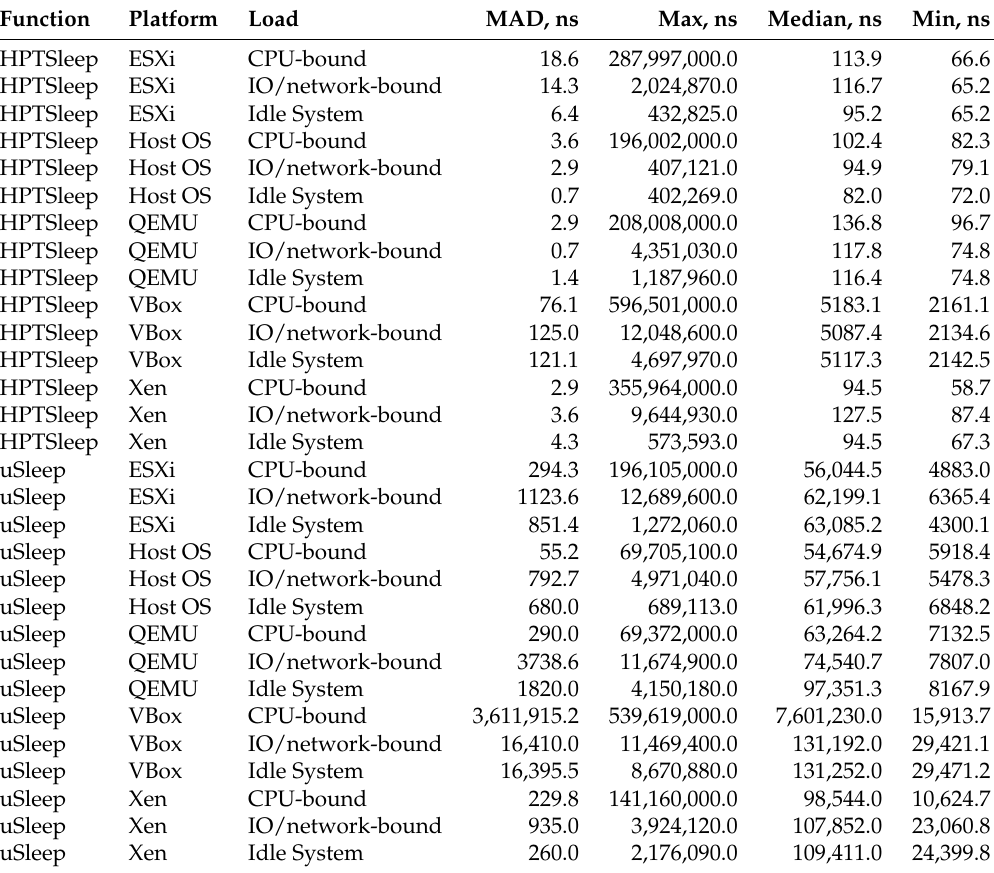
Table 2. Results for all experiments with sleep